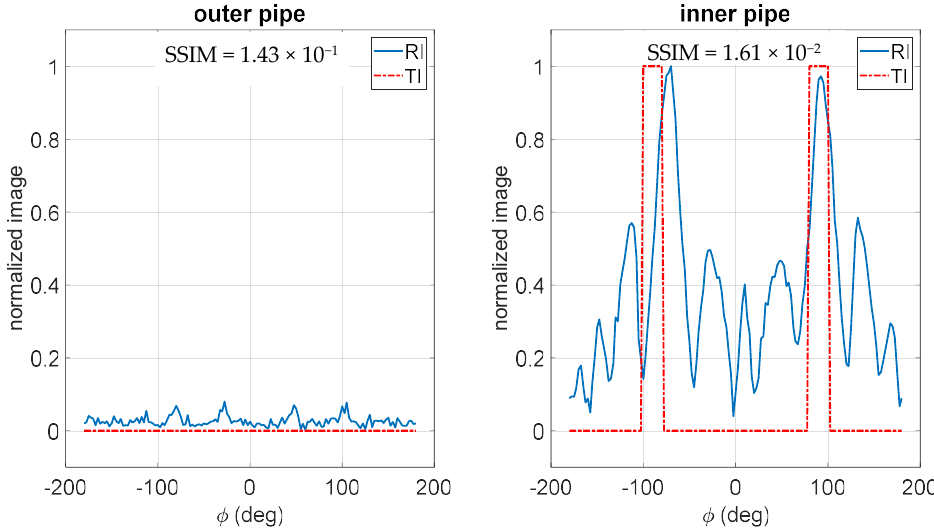
Figure 7. Reconstructed images when the property of the inner pipe’s liquid is not correct for PSFs (RI: reconstructed image and TI: true image).